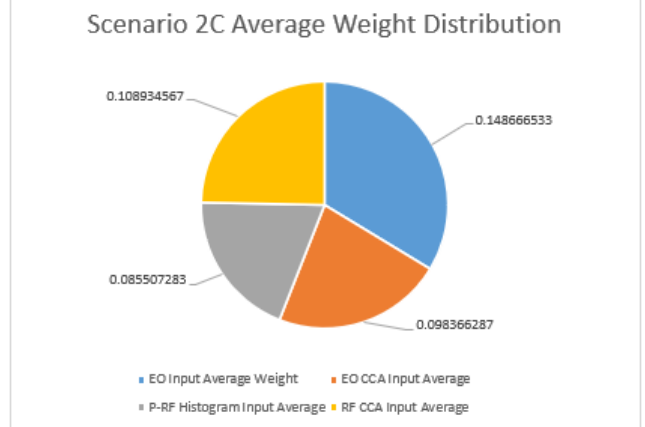
Figure 6. Comparison of average weights for Scenario 2C.